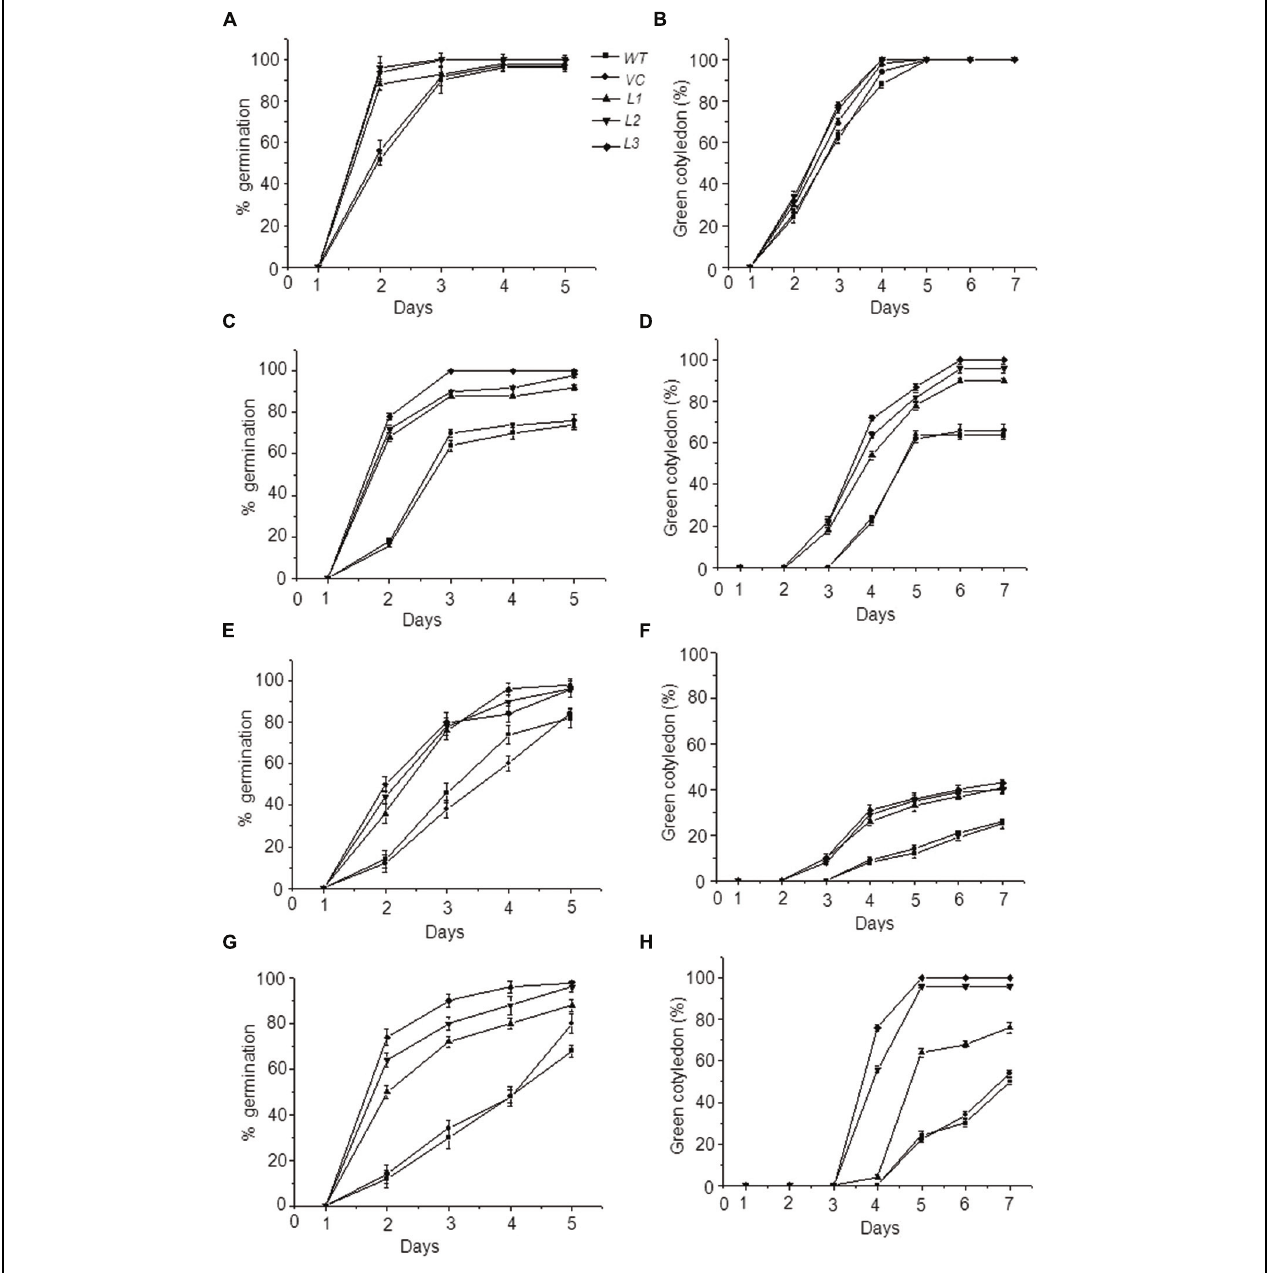
FIGURE 5 | Germination and seedling establishment of OsHSP18.2 overexpressing seeds under abiotic stresses. Germination percentage (A,C,E,G) and green cotyledon emergence (B,D,F,H) of WT, VC, and transgenic seeds overexpressing OsHSP18.2 scored under (A,B) Control conditions, (C,D) Heat (45 ◦ C), (E,F) Salt (150 mM NaCl), and (G,H) Dehydration ( − 0.4 MPa PEG). Age matched seeds were surface sterilized and plated on either 1 / 2 MS or 1 / 2 MS supplemented for various stresses. Plates were stratified at 4 ◦ C for 3 days and transferred to growth chamber at 22 ± 2 ◦ C. Values are mean ± SE of three independent sets ( n =